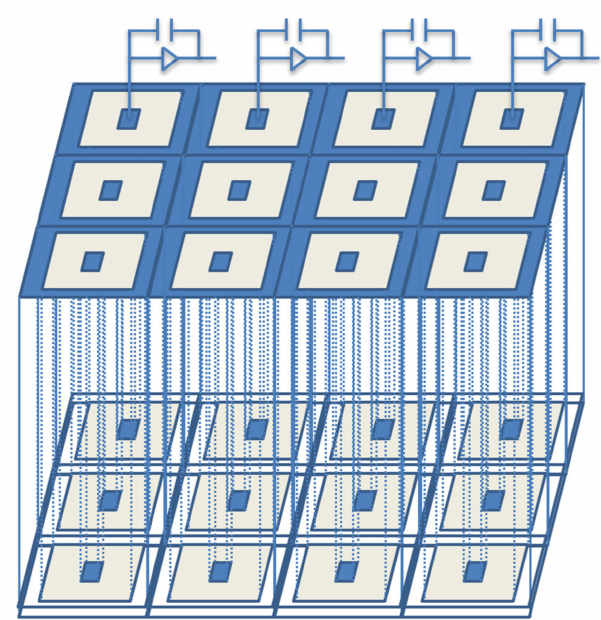
Figure 13. The schematic of a 4 × 3 array of the ultra-fast 3D-trench electrode detector